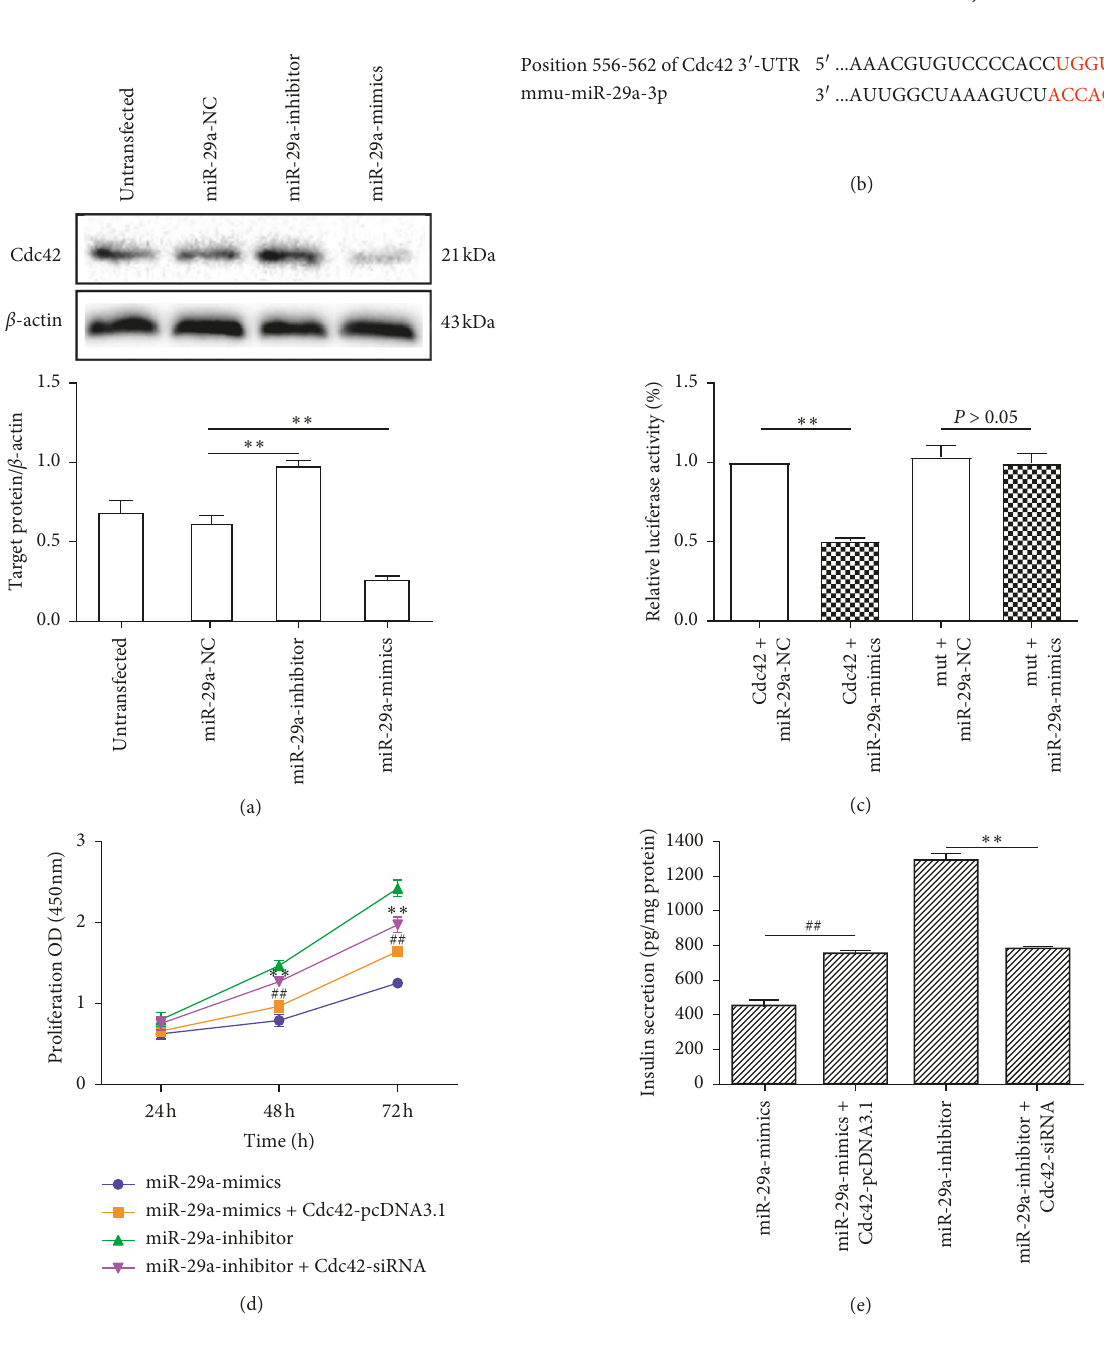
Figure 3: Effects of miR-29a/Cdc42 on MIN6 cells. (a) Effects of miR-29a on Cdc42 protein expression. Western blot to detect Cdc42 protein expression after transfection with miR-29a mimic and inhibitor ( n � 3). ∗∗ P < 0 . 01, compared with miR-29a NC group, as assessed by paired Student’s t -test. (b) Bioinformatics analysis of the miR-29a binding site in the Cdc42 mRNA 3 ′ -UTR. (c) Luciferase reporter assays indicate that miR-29a binds to Cdc42 mRNA in MIN6 cells. ∗∗ P < 0 . 05, compared with nonmutated Cdc42 3 ′ UTR+miR-29a-NC group, as assessed by paired Student’s t -test. (d) Effects of miR-29a/Cdc42 on MIN6 cell proliferation. CCK assay to detect MIN6 cell proliferation after simultaneous overexpression of miR-29a and Cdc42, and after simultaneous interference with miR-29a and Cdc42 expression ( n � 3). ∗∗ P < 0 . 01, compared with miR-29a mimic group, and ## P < 0 . 01, compared with miR-29a inhibitor group, as assessed by one-way ANOVA, followed by Fisher’s least significant difference test. (e) Effects of miR-29a/Cdc42 on insulin secretion by MIN6 cells. ELISA to detect insulin secretion by MIN6 cells after transient transfection with miR-29a mimic +Cdc42-pcDNA3.1 and miR-29a inhibitor +Cdc42- siRNA under high-glucose (20.0 mM) stimulation ( n � 3). ∗∗ P < 0 . 01, compared with miR-29a inhibitor group, and ## P < 0 . 01, compared with miR-29a mimic group, as assessed by paired Student’s t -test. Data are shown as mean ± SD. NC: negative control; mmu: mouse lemur; 3p: mmu-miR-29a is produced from the 3 ′ end arm of the double strand of miR-29a; mut: